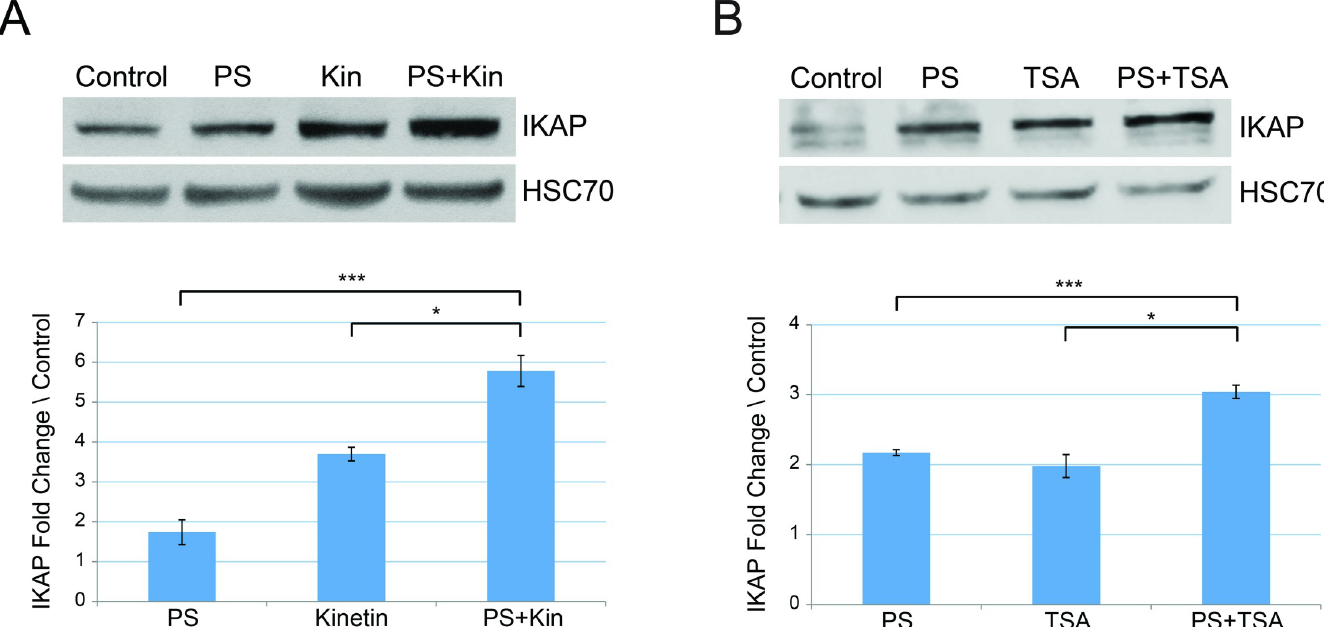
Fig 1. Combined treatments with phosphatidylserine elevates IKAP protein level more efficiently than either drug alone. FD cells were treated for 5 days either with (A) 50 μ g/ml PS or 10 μ M kinetin (Kin) or the combination of both drugs, and (B) 50 μ g/ml PS or 100 ng/ml TSA or the combination of both drugs. Upper panels: Western blotting of FD cell lysates after indicated treatments. Proteins were extracted, and western blots were analyzed by using anti-IKAP antibody or HSC-70 antibody; the latter was used as a protein-loading control. Lower panels: Quantification of IKAP fold change levels normalized to HSC70 and relative to control (vehicle only). All quantifications were done using FusionCapt software. Asterisks denote statistically significant differences ( � P � 0.05 and ��� P � 0.005) relative to each control; Student’s t -test.